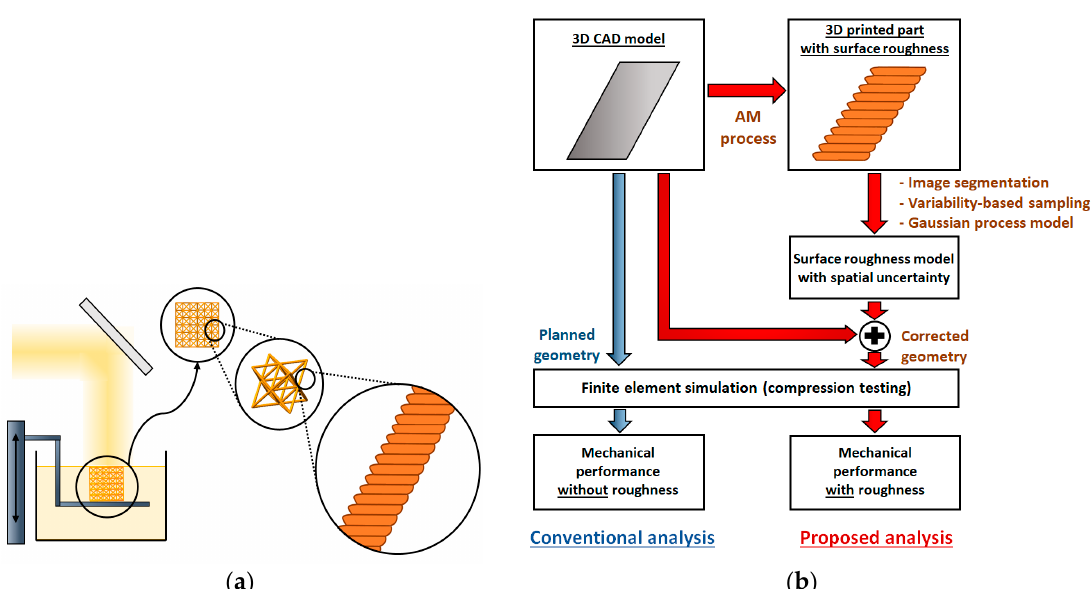
Figure 1. Schematic description of probabilistic modeling framework for an additively manufactured part: ( a ) Manufacturing process of a microlattice structure: a hierarchical structure of a unit cell consisting of multiple struts; ( b ) A probabilistic modeling framework for surface roughness estimation and mechanical behavior of an additively manufactured geometry.